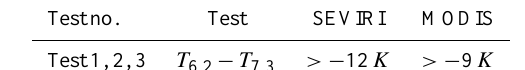
Table 3. SEVIRI (i.e. from Krebs et al., 2007) and MODIS thresh-